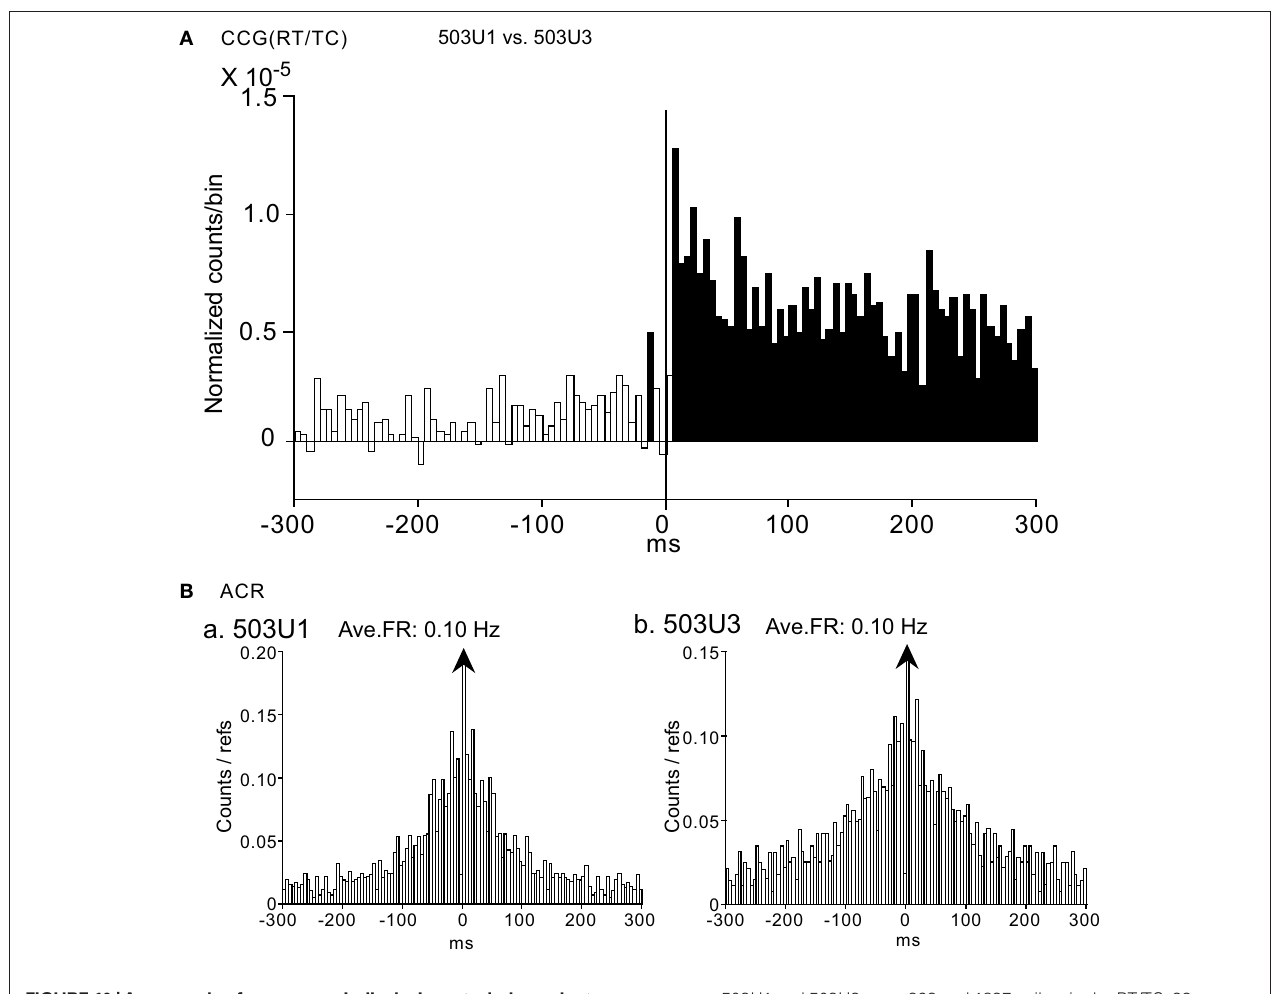
Figure 10 | An example of a neuron pair displaying a task-dependent peak with trigger-like activity in the CCgs. (A) Difference CCGs for a pair of CA1 pyramidal neurons (503U1, reference cell; 503U3, target cell) in the RT/TC task. Note that one neuronal discharges (503U1) precede activity of the other neuron (503U3). Total spikes analyzed in each CCG in each task for